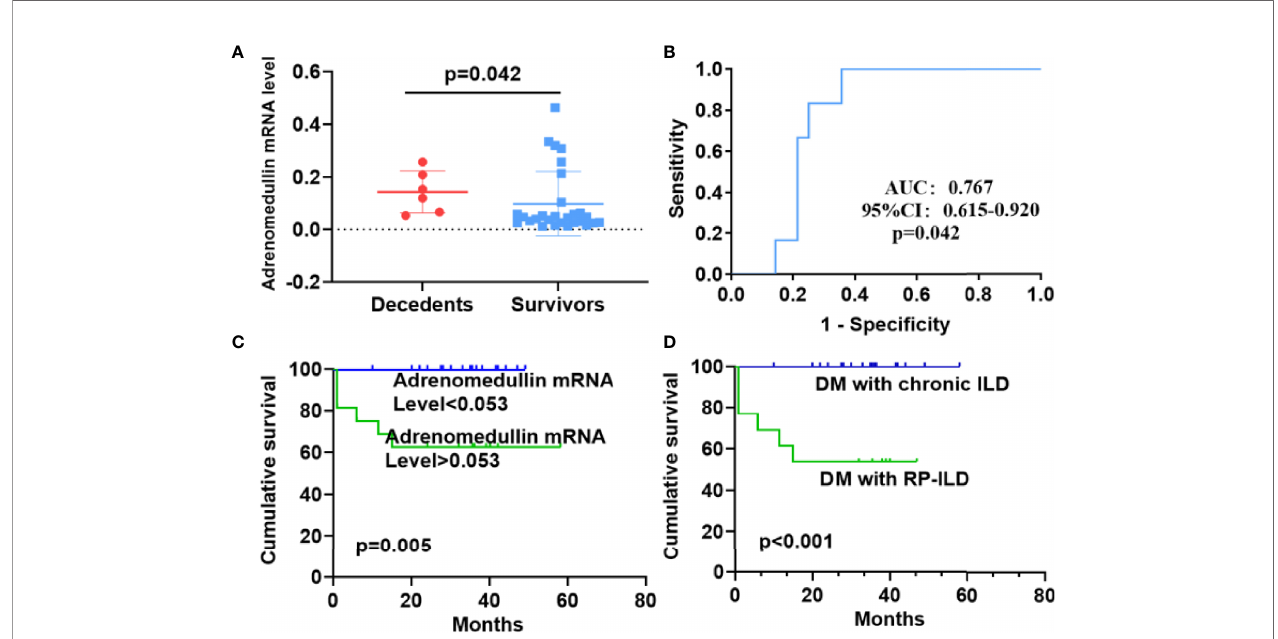
FIGURE 5 | Prognostic value of adrenomedullin in DM patients with ILD and survival analysis. (A) The adrenomedullin mRNA levels in PBMCs were higher in decedents than survivors among DM patients with ILD. (B) Receiver operating characteristic curve analyses to predict the mortality of DM patients with ILD. (C) The cumulative survival rate was signi fi cantly lower in the group with adrenomedullin mRNA levels >0.053 than in those with adrenomedullin mRNA levels <0.053(62.5% vs 100%, log-rank test, P=0.005). (D) Kaplan – Meier curves showed that the cumulative survival rate was signi fi cantly lower in DM patients with RP-ILD than in those without RP-ILD (53.8% vs 100%, log-rank test, P < 0.001). DM, dermatomyositis; ILD, interstitial lung disease; RP ‐ ILD, rapidly progressive